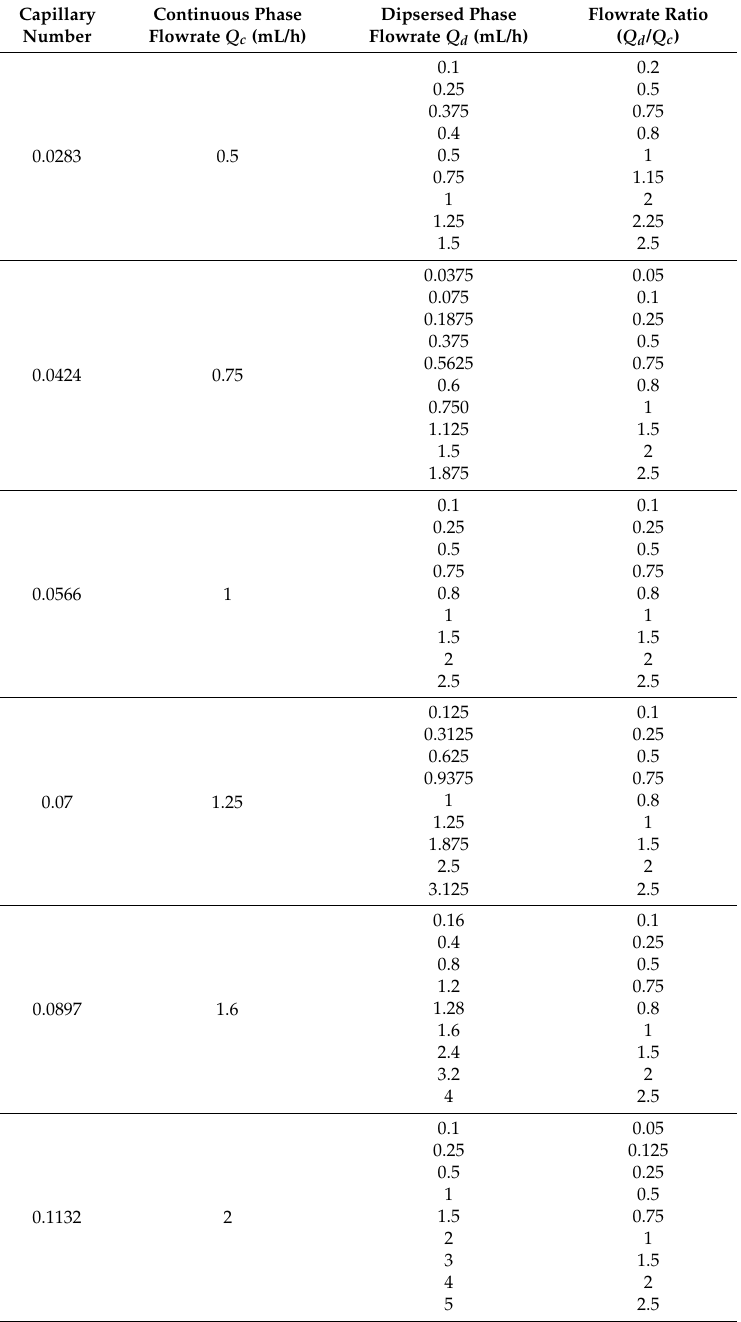
Table 2. Summary of